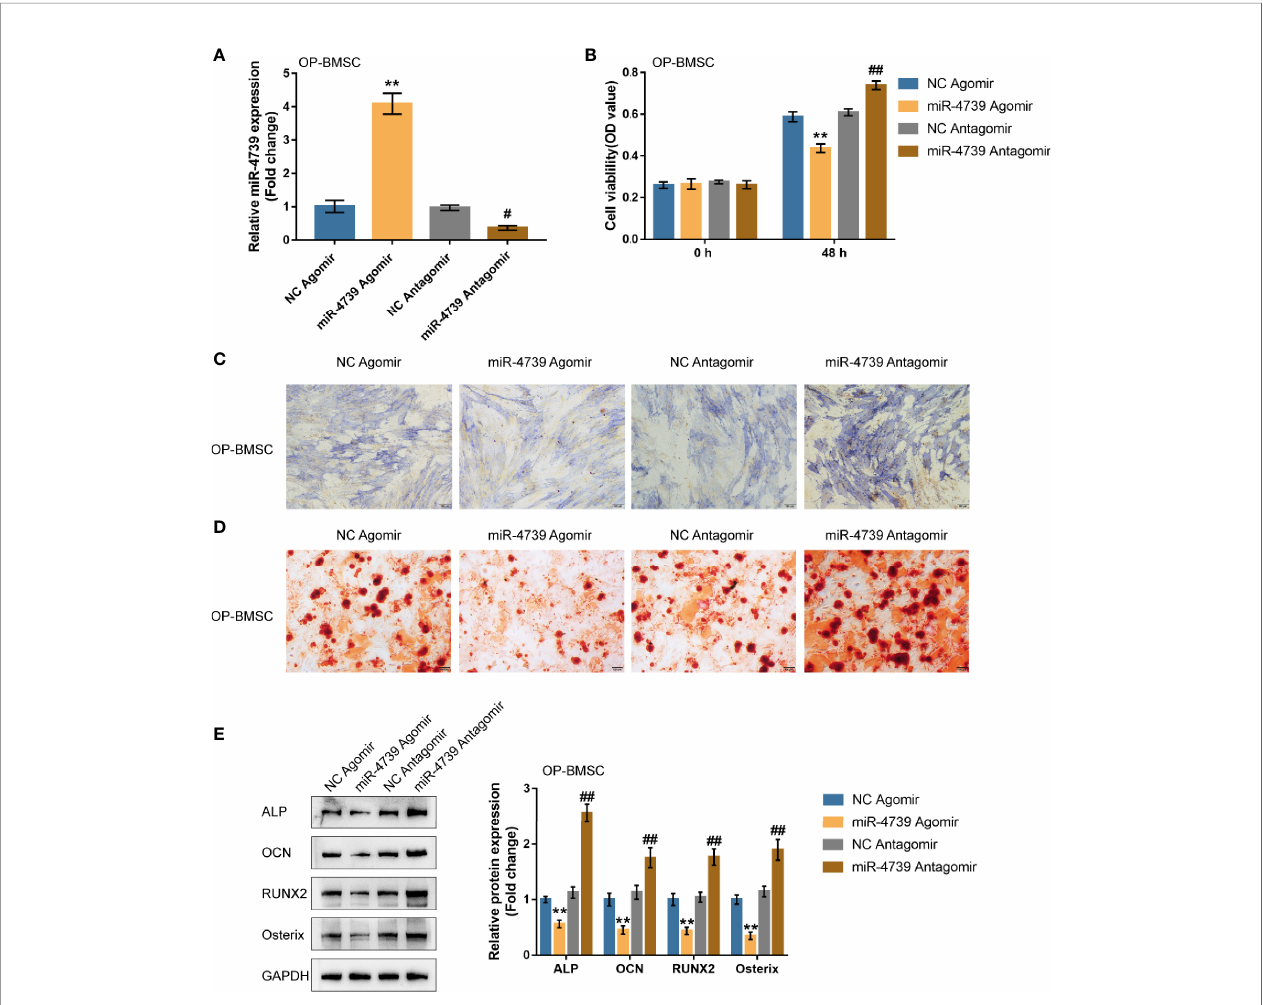
FIGURE 3 | Effects of miR-4739 overexpression and inhibition on osteoporotic BMSC osteogenic differentiation (A) miR-4739 overexpression or inhibition was achieved in osteoporotic BMSCs by transfecting agomir-4739 or antagomir-4739; miR-4739 expression was con fi rmed using qRT-PCR. n=3. (B) Osteoporotic BMSCs were transfected with agomir-4739 or antagomir-4739 and examined for cell viability by CCK-8 assay (n=3). Then, osteoporotic BMSCs were transfected with agomir-4739 or antagomir-4739, induced towards osteogenic differentiation for 21 days, and examined using ALP staining on day 14 of osteogenic induction (C) ; examined for the formation of mineralized nodules using Alizarin red staining on day 21 of osteogenic induction (D) ; examined for the protein levels of ALP, OCN, Runx2, and Osterix using Immunoblotting on day 14 of osteogenic induction (E) (n=3). ** P < 0.01, compared to NC agomir; # P < 0.05, ## P < 0.01, compared to NC